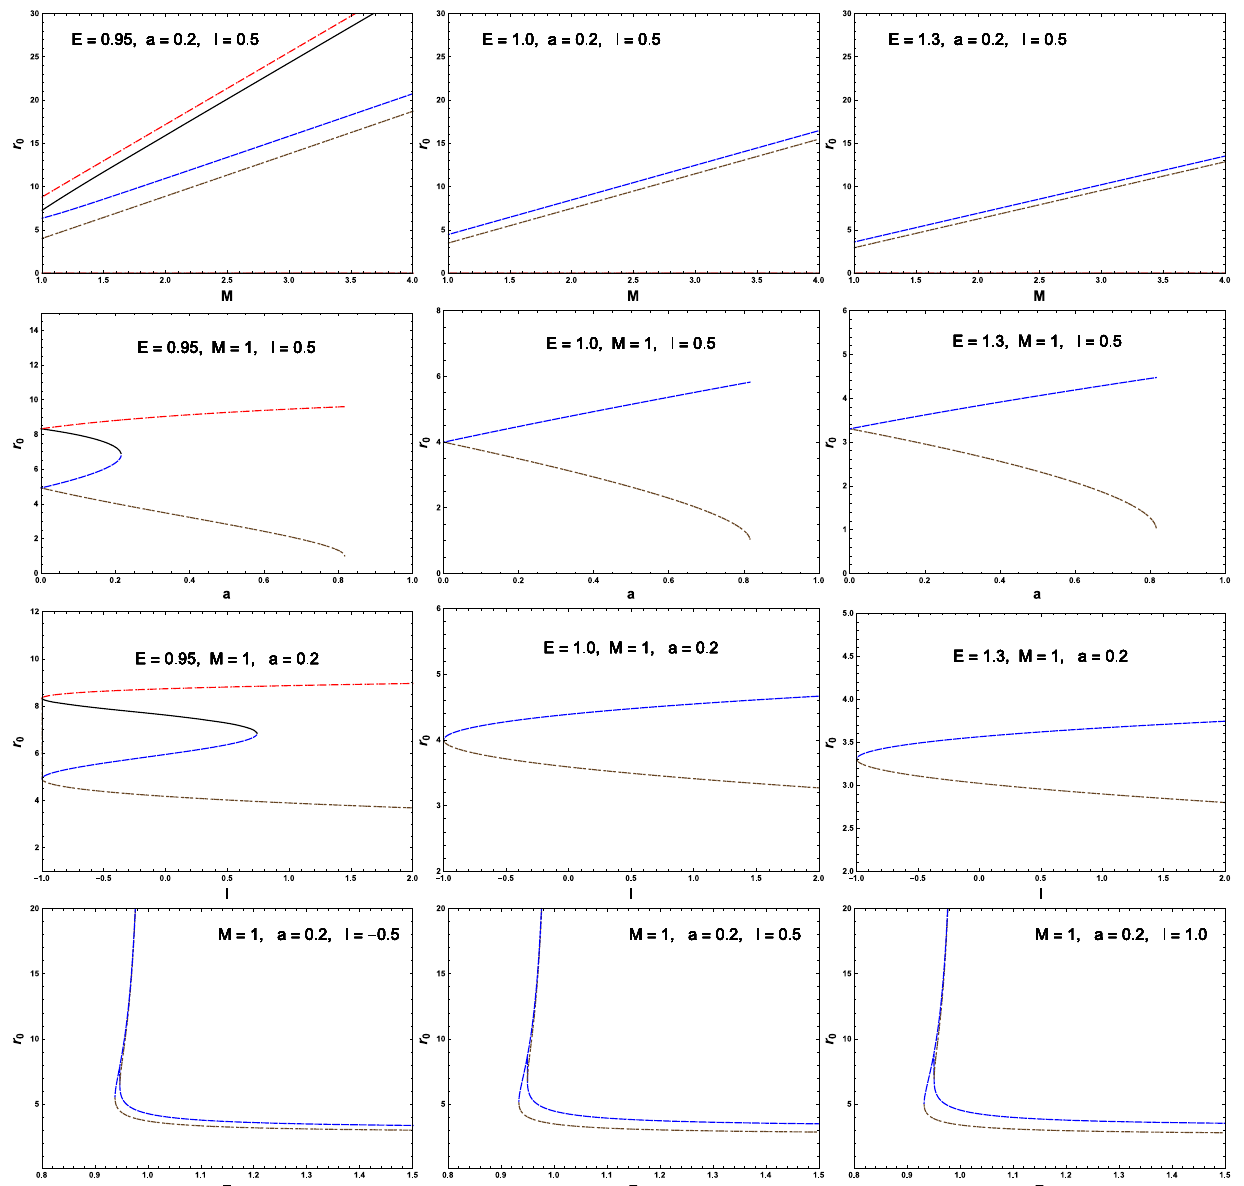
Fig. 2 The change of the circular orbit radius r 0 with the black hole parameters M , a , l and the particle’s energy E in the rotating black hole spacetime (4) in Einstein-bumblebee theory. In each panel, the red or black line denotes the unstable orbit, the blue or brown line corresponds to the stable orbit